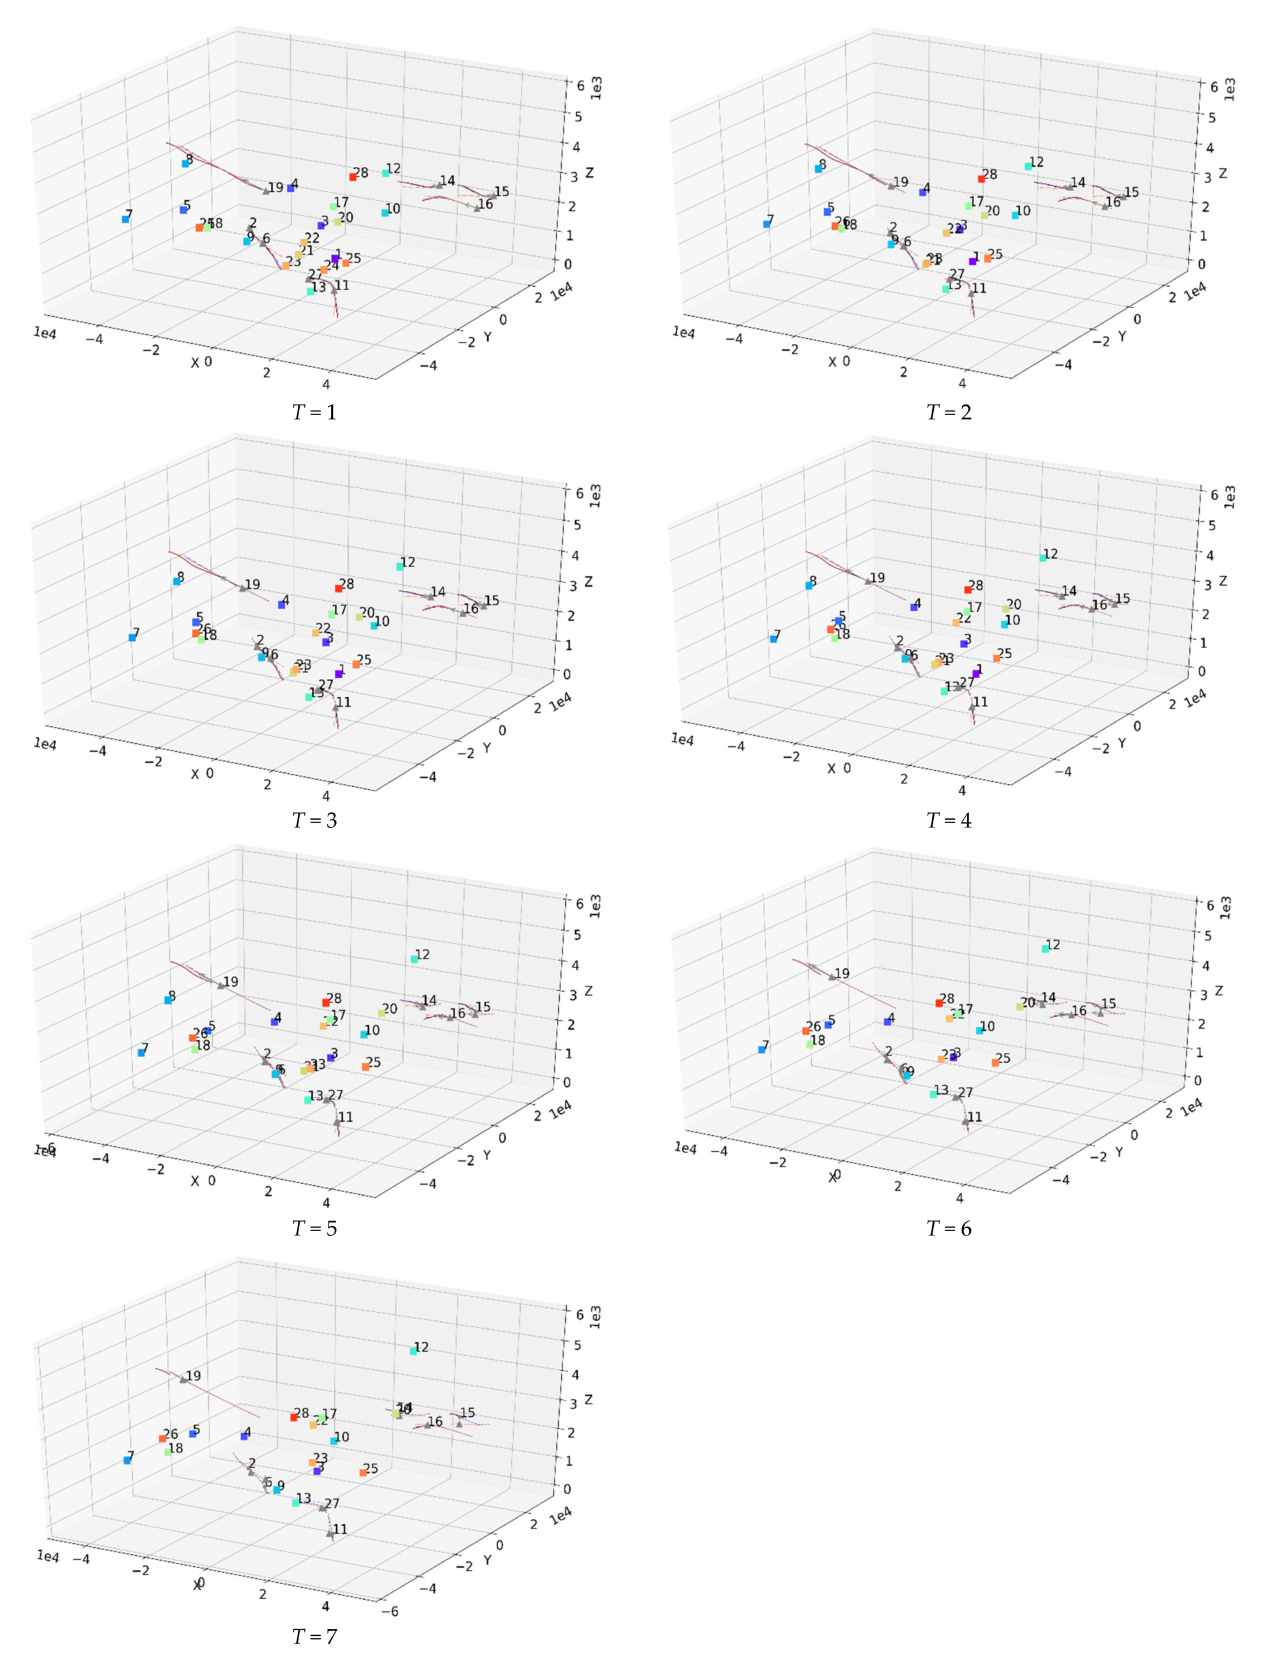
Figure 11. Scene